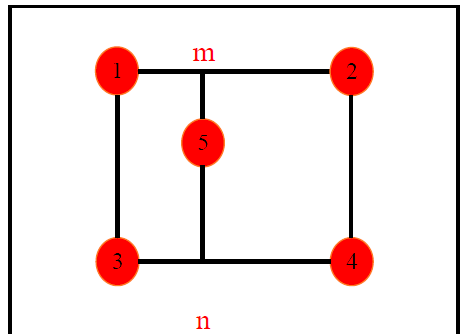
Figure 3. Bilinear interpolation, where points 1–4 are known points and the coordinates and pixel values of point 5 are calculated.